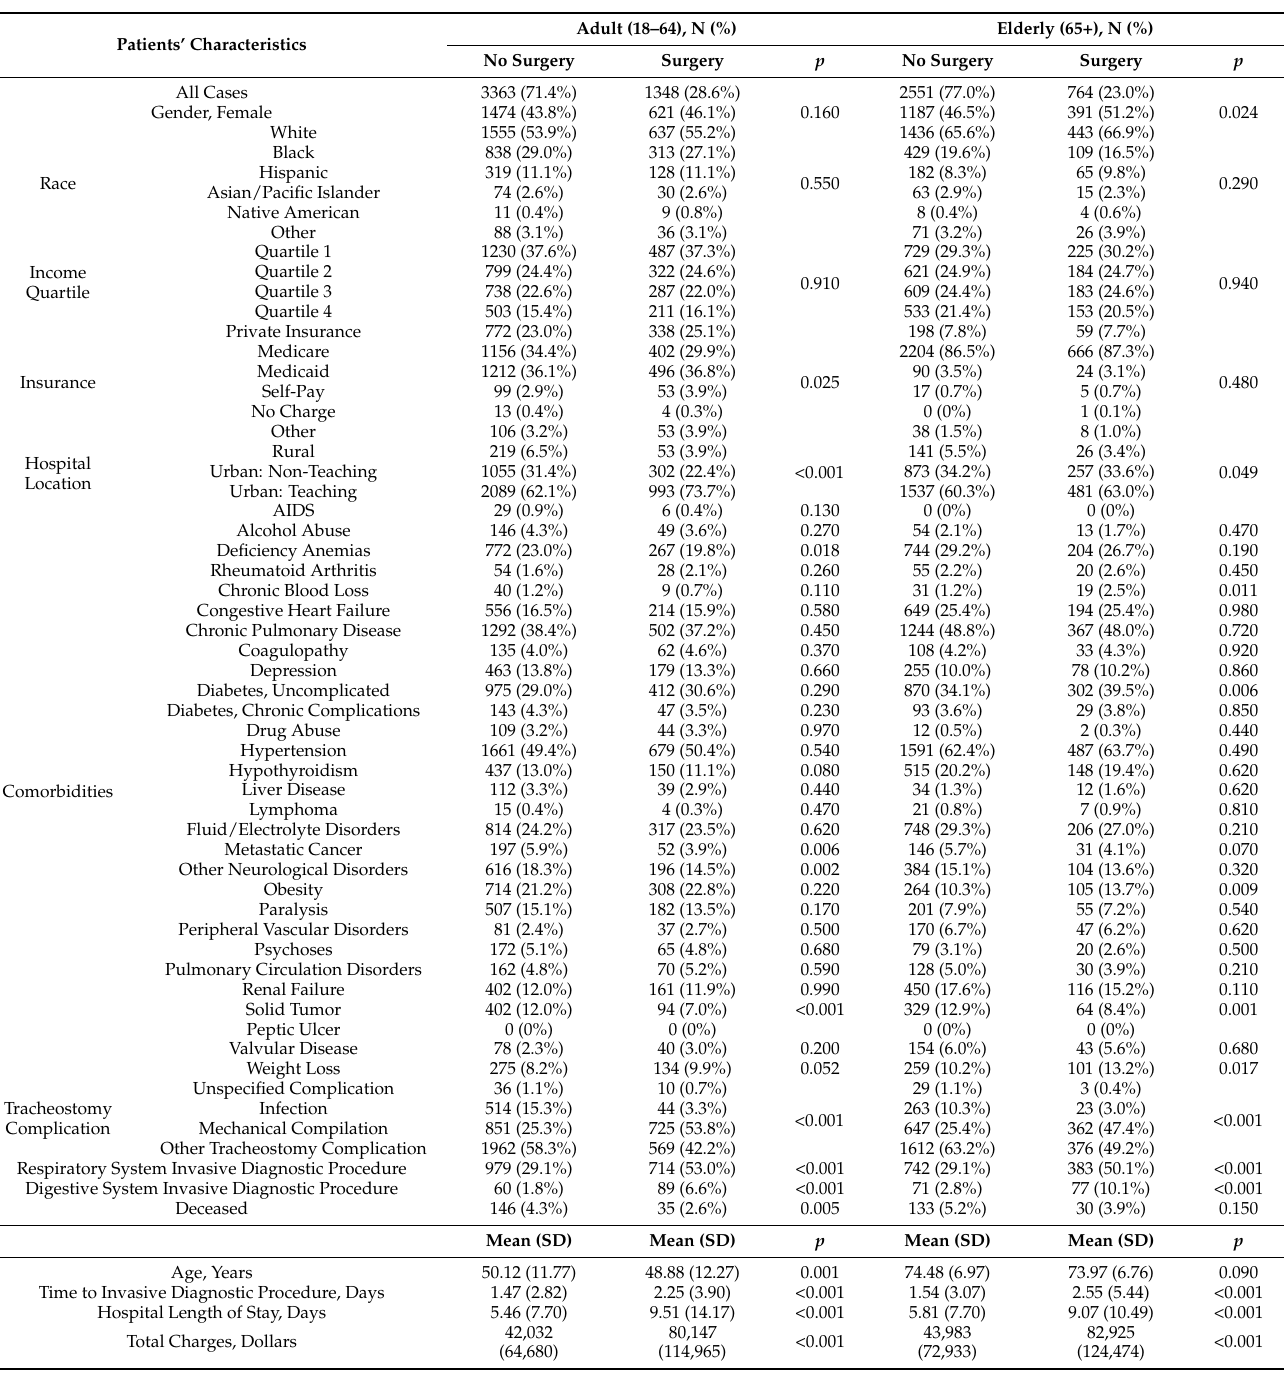
Table 4. Characteristics of emergently admitted patients with the primary diagnosis of tracheostomy complications. Data were stratified according to surgery status, NIS